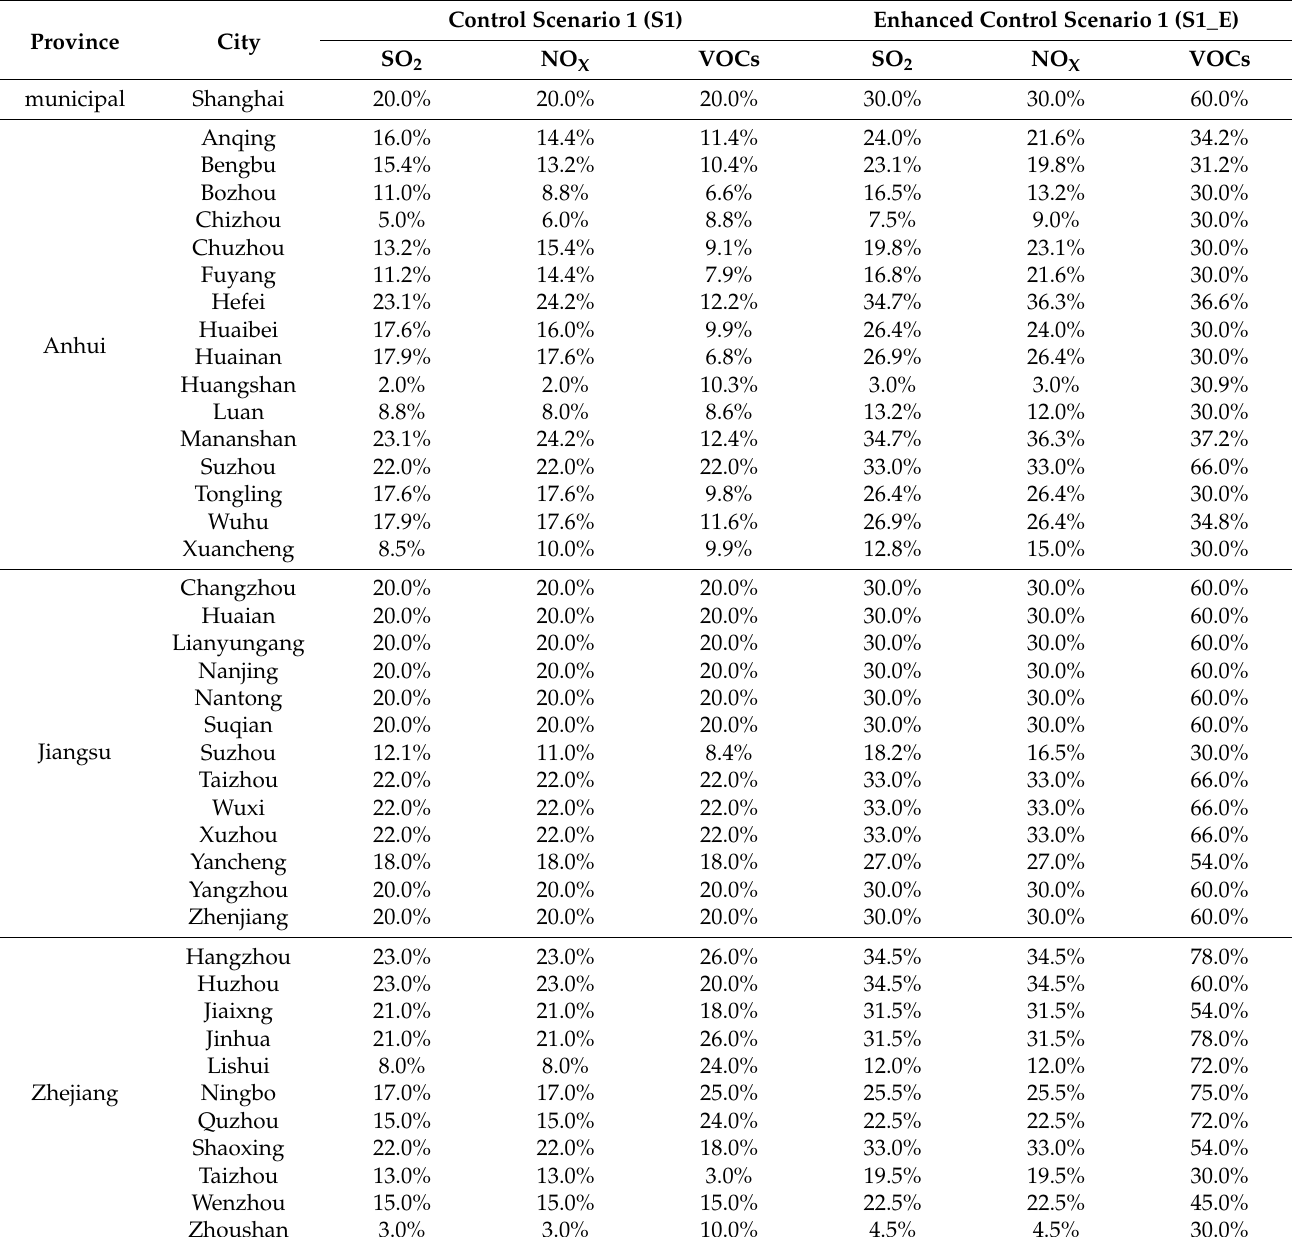
Table 1. The emission control schemes on the basis of National Total Emission